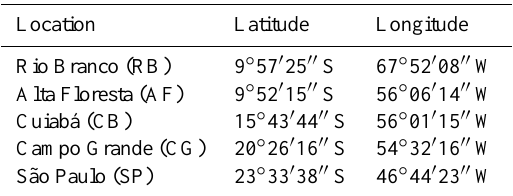
Table 2. Geographical coordinates of the five measurement sites used in this study.